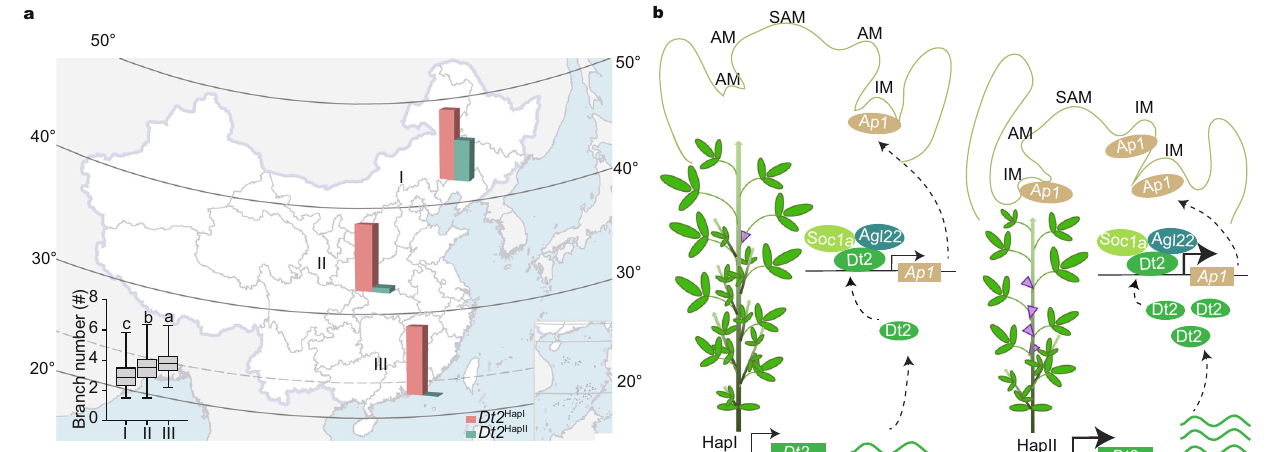
Fig. 5 | Geographic distribution of different Dt2 haplotypes and a proposed working model of Dt2 in controlling branch number in soybean. a Geographic distributionof Dt2 haplotypesinthreedifferentecoregions.Thecolumndiagramis the percentage ratio between Dt2 HapI and Dt2 HapII . The bottom left box plot repre- sents the branch number comparison of accessions in I ( n =695 accessions), II ( n =821 accessions) and III ( n =222 accessions) ecoregions. Data are the mean± SEM. In box plot (drawn by R 4.1.1 software), the center line indicates the median,